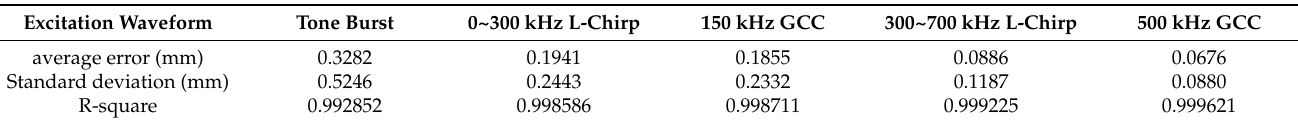
Table 3. Average error and standard deviation of different